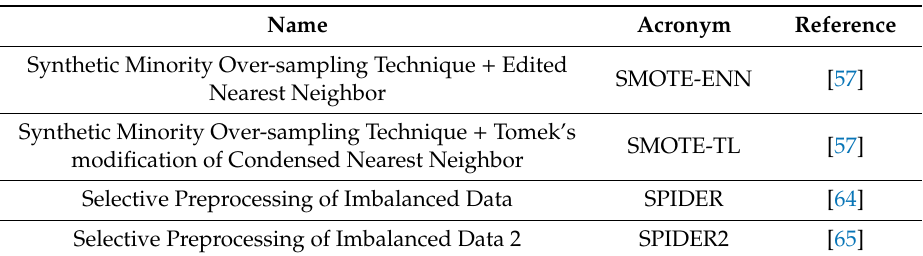
Table 5. Hybrid algorithms